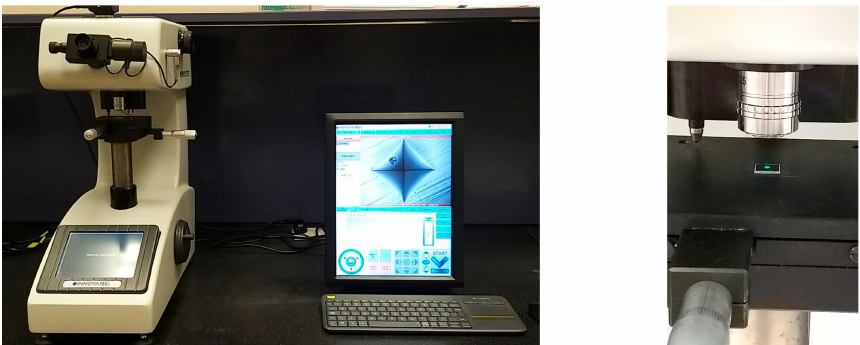
Figure 5. Hardness testing using Innovatest hardness testing machine (Nova 130, Maastricht,